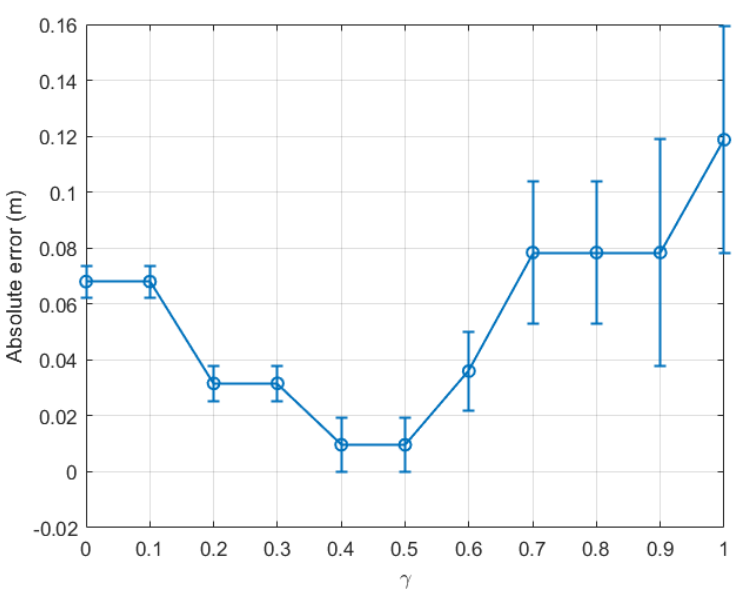
Figure 14. Outdoor walking (dataset 6): absolute error of the last time window ( tw 18 ) with respect to γ ∈ [ 0,1 ]